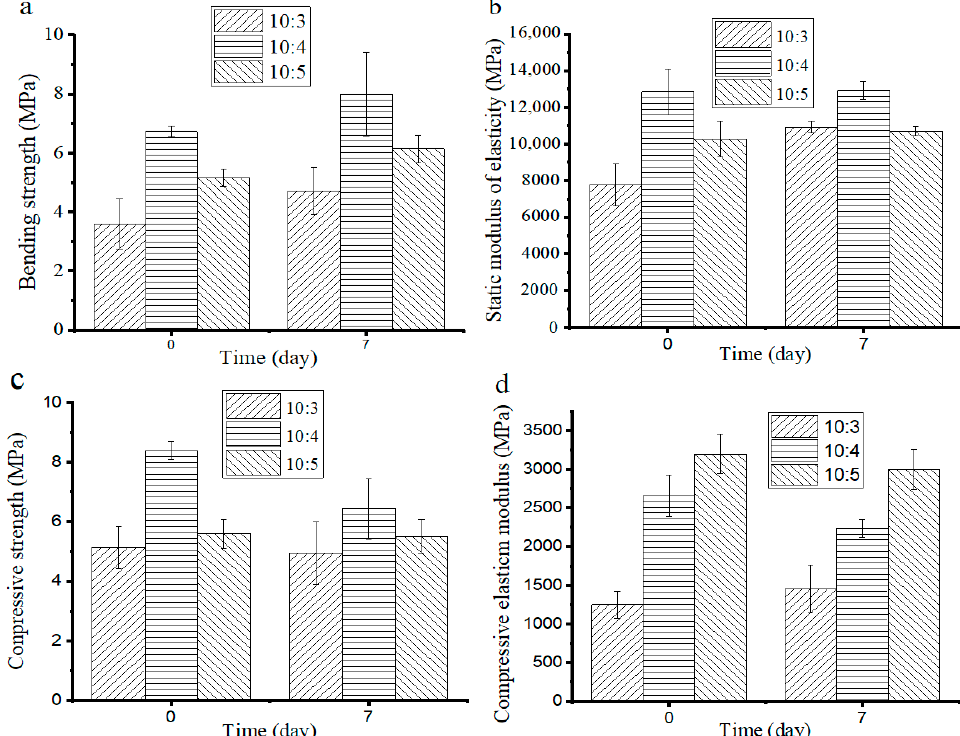
Figure 9. The ( a ) static bending strength, ( b ) static modulus of elasticity, ( c ) compressive strength, and ( d ) compressive elastic modulus of the composites.